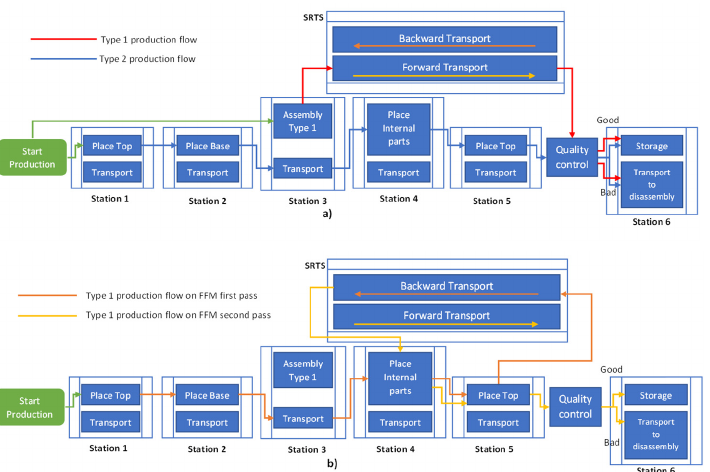
Figure 4. Manufacturing flow for ( a ) single-layer product on FFM and multilayer product on FMC and ( b ) multilayer product on FFM.